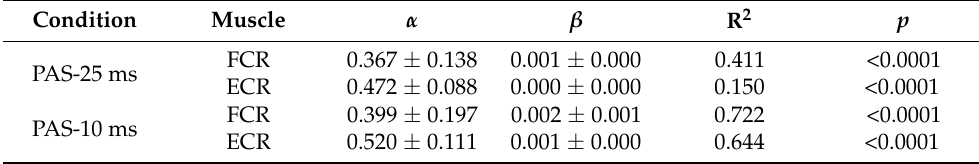
Table 2. Assessment of the model